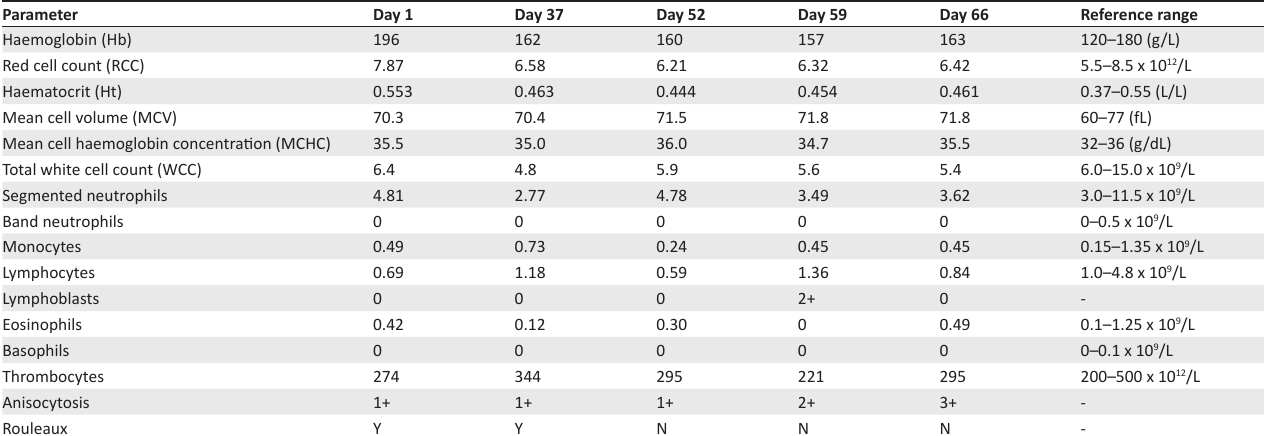
FIGURE 2: Fine needle aspirate cytology of the clitoral mass (shown in Figure 1). FIGURE 3: Vulva: Canine, diffuse small cell lymphoma (Tissue TABLE 1: Haematology values.